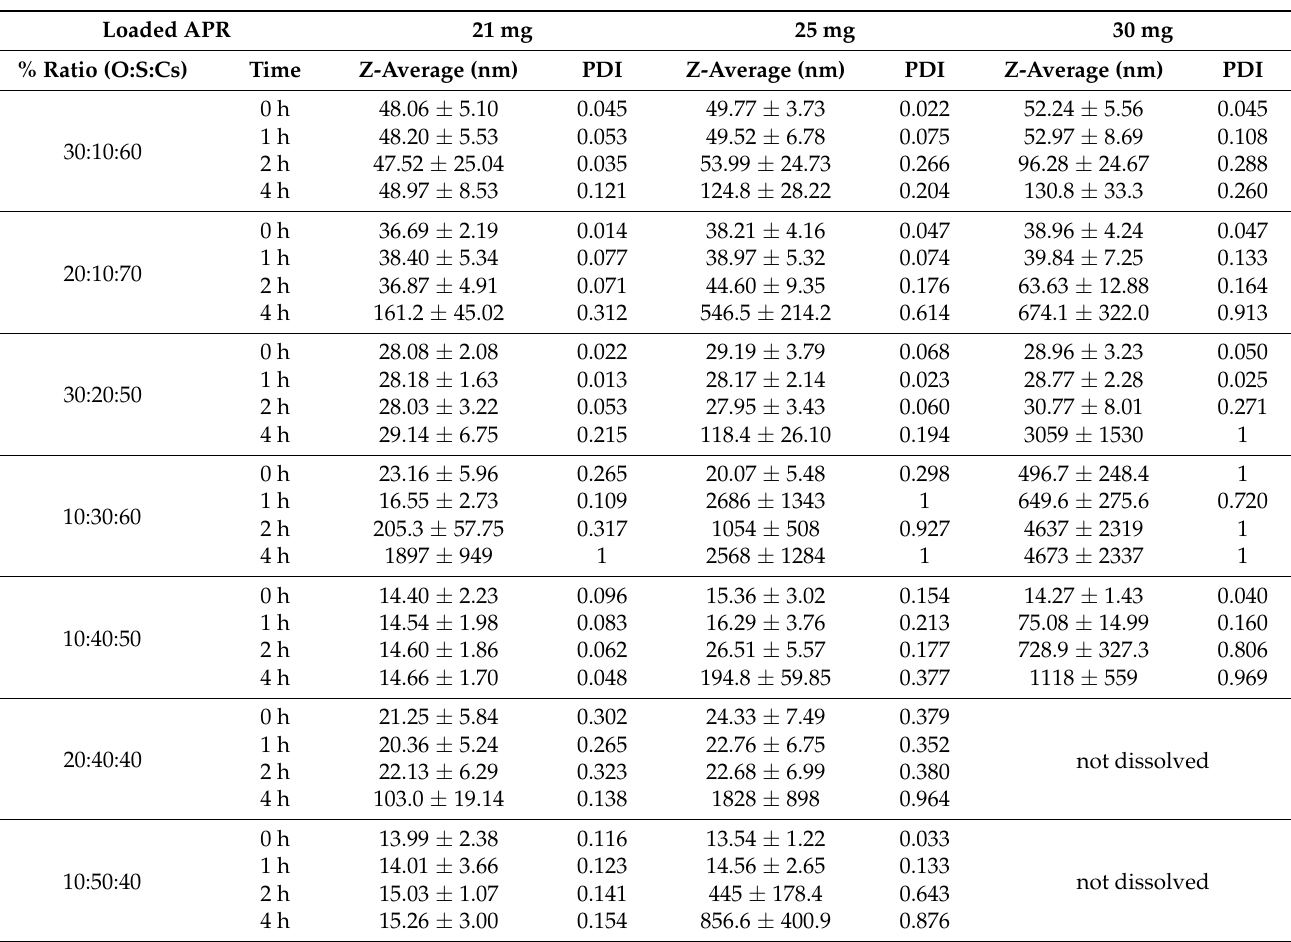
Figure 8. The loading capacity of SNEDDS preconcentrates at 37 ◦ C. Table 5. Stability of droplets after dilution with distilled